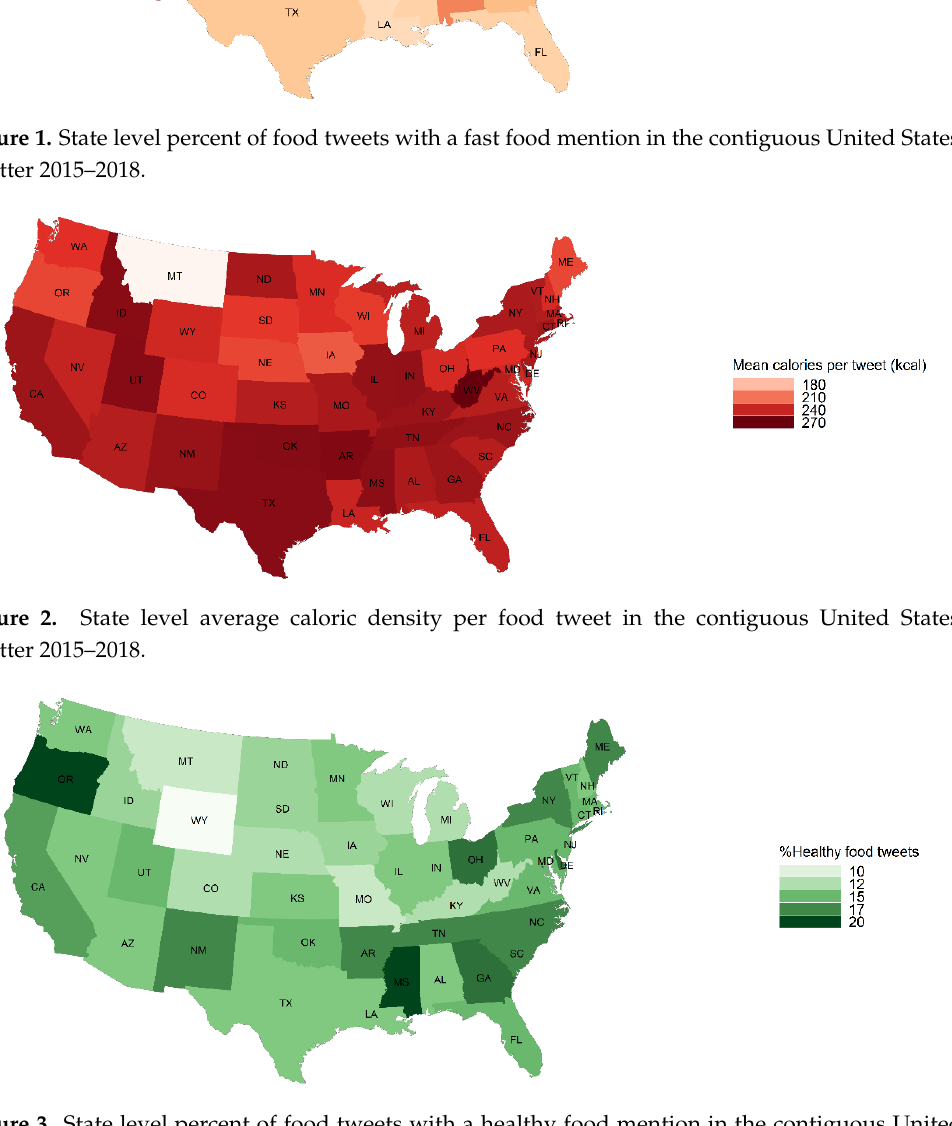
Figure 1. State level percent of food tweets with a fast food mention in the contiguous United States, Twitter 2015–2018.